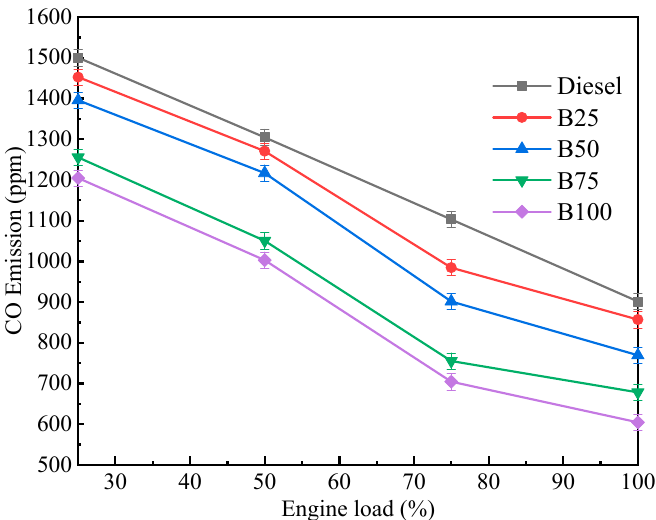
Figure 23. CO emission comparison of biodiesel blends and diesel under different engine loads [226].